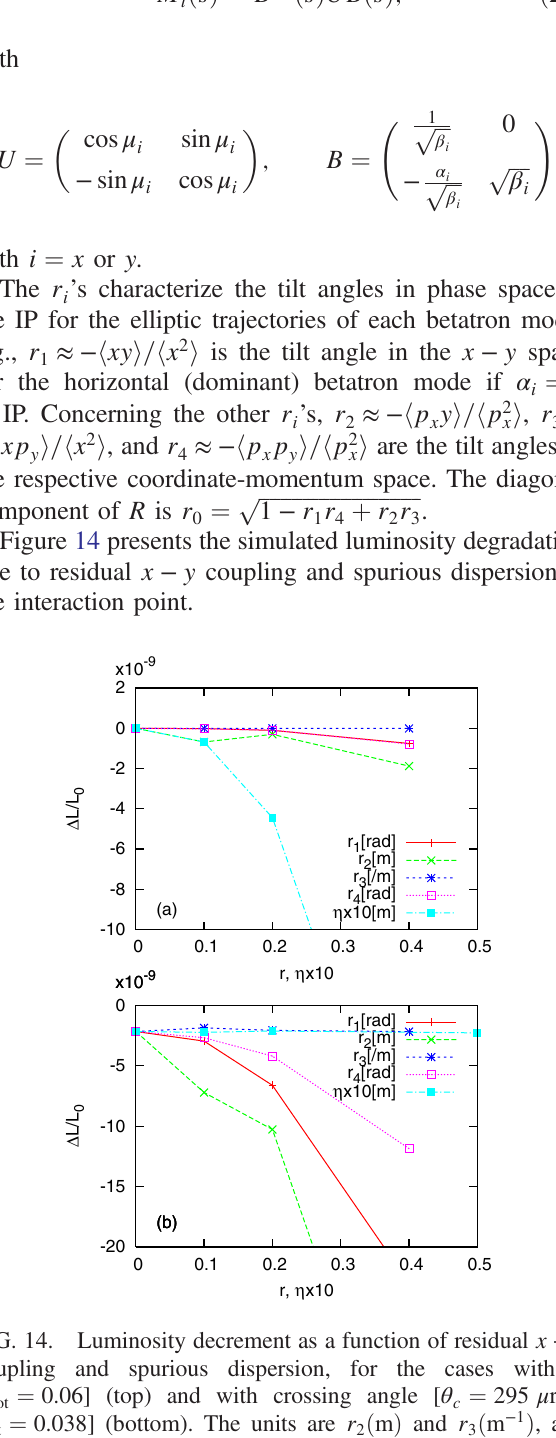
295 μ rad, c ¼ − 1 Þ , and r 2 ð m Þ and 3 ð m